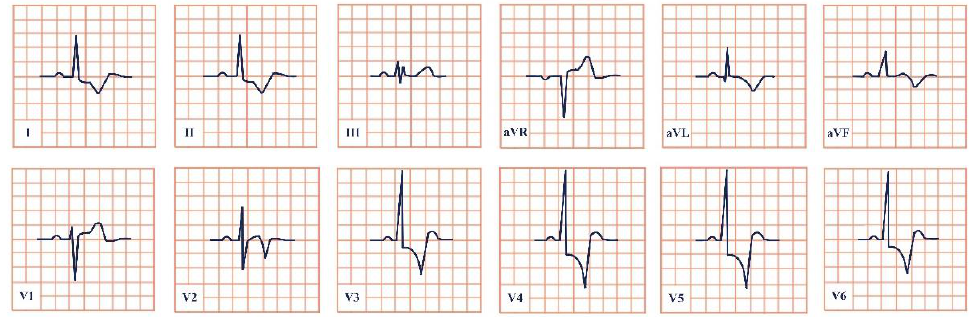
Figure 5. Electrocardiogram aspect in Yamaguchi syndrome.